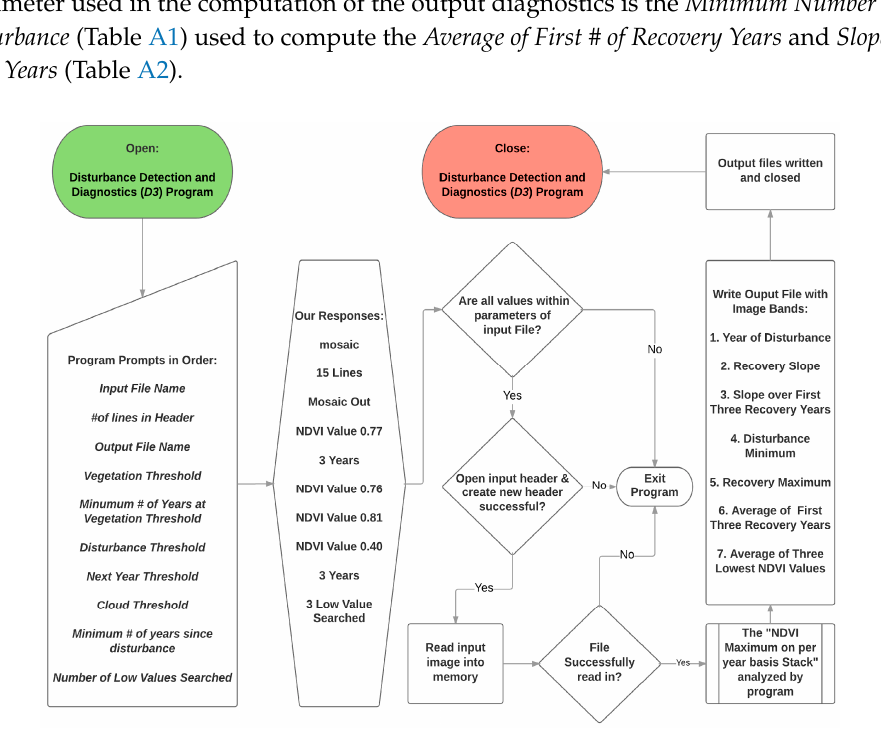
Table A1. User-Specified Parameters.